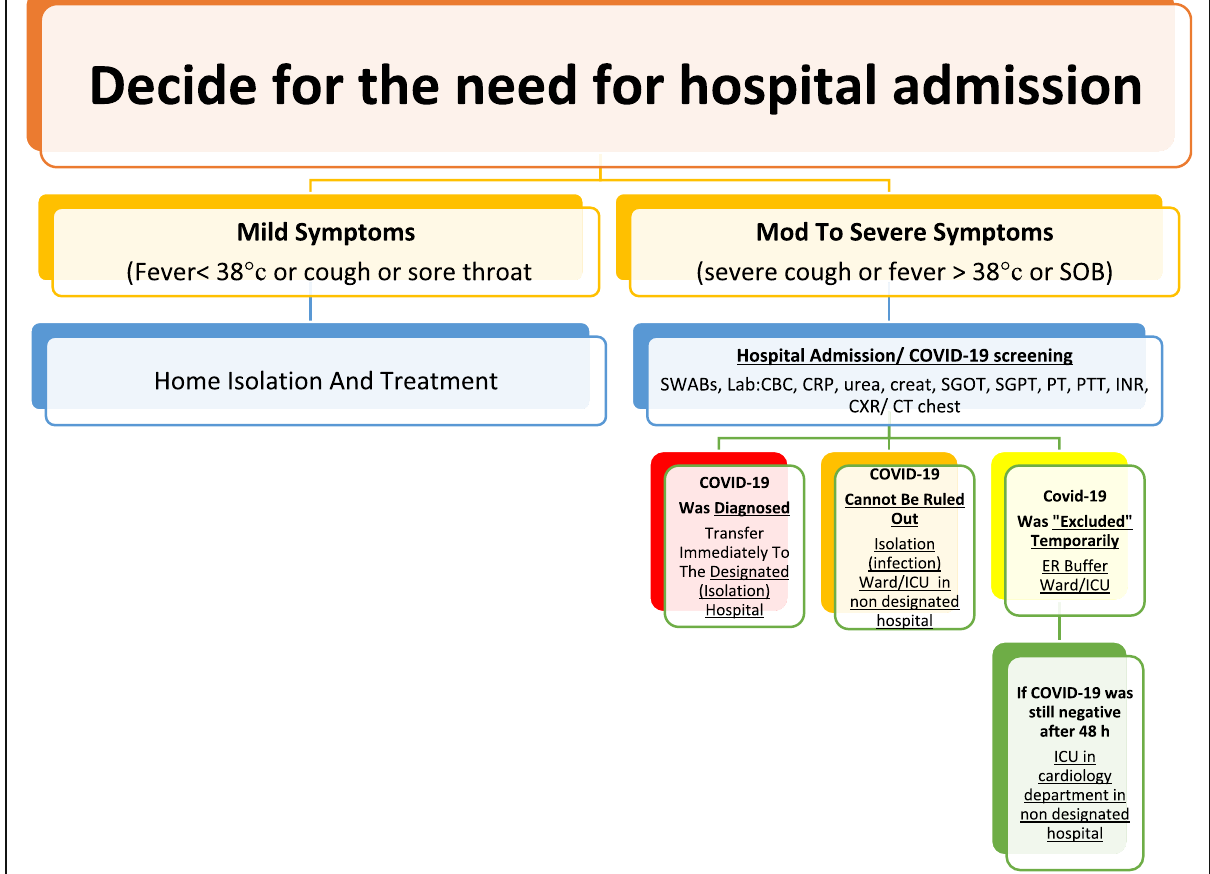
Fig. 1 Management of cardiac patient with respiratory symptoms (suspected COVID-19) in a non-designated